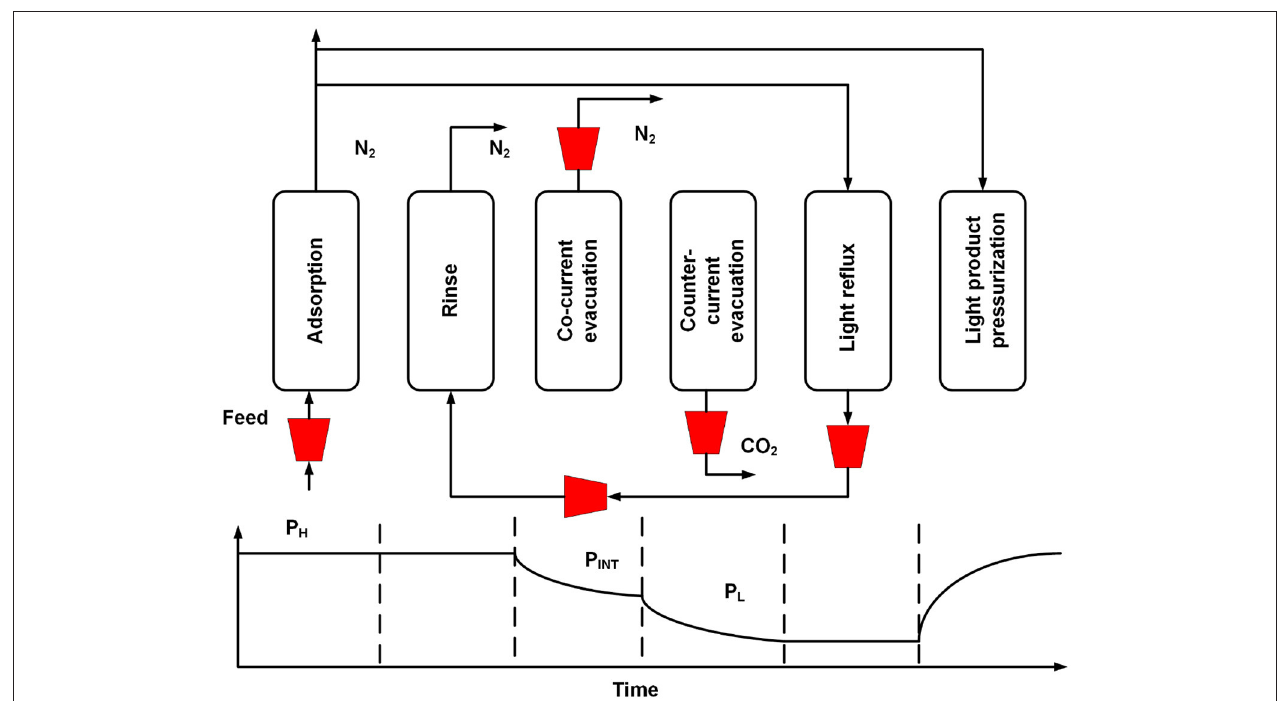
FIGURE 4 | Schematic of the 6-step VSA